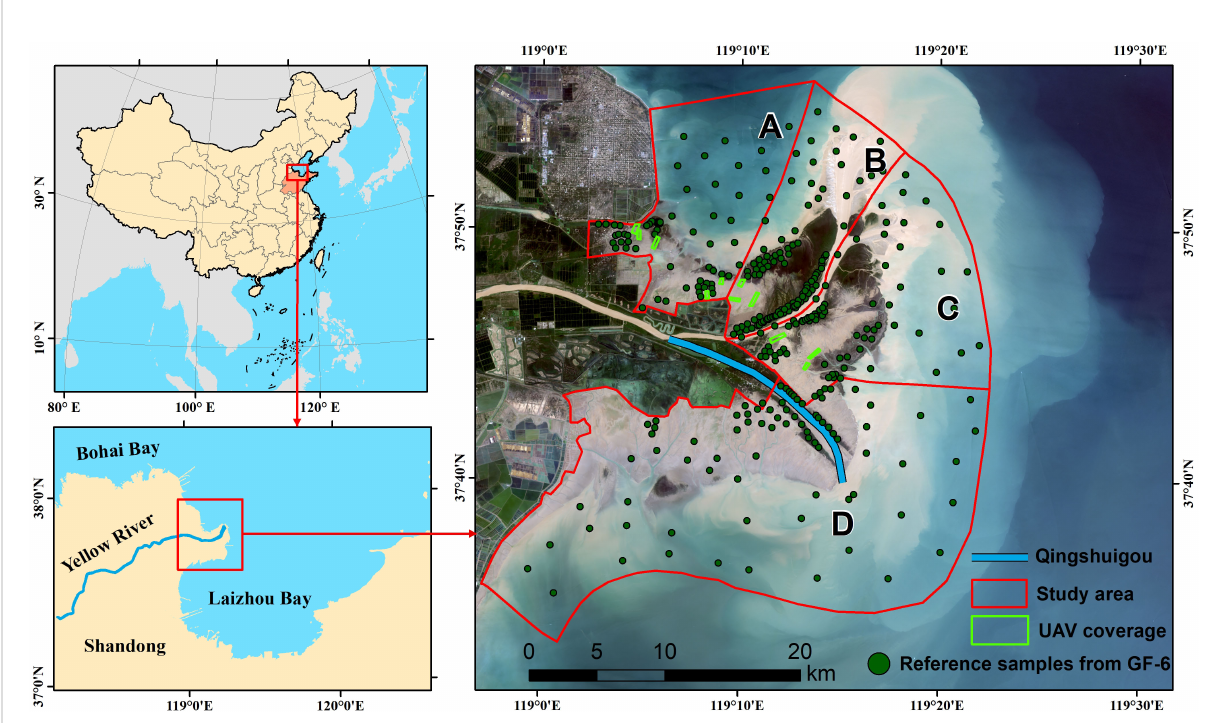
FIGURE 1 Location of the study area. Qingshuigou course was the old river channel before 1996. The study area is divided in Zone (A – D) based on the distribution of arti fi cial groins and the river